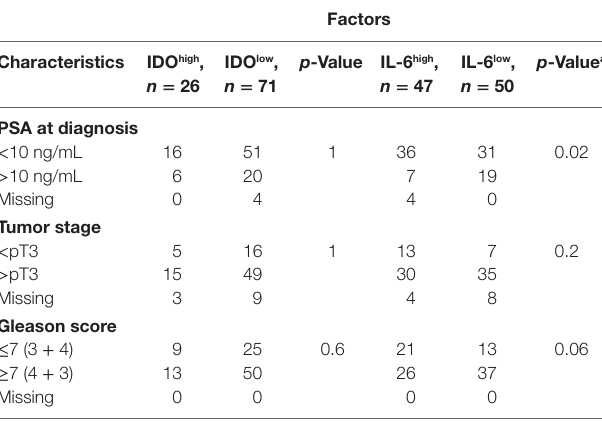
TaBle 3 | Univariate Cox regression analysis of the risk of biochemical recurrence associated with indoleamine 2,3-dioxygenase (IDO) and interleukin (IL)-6 gene expression.